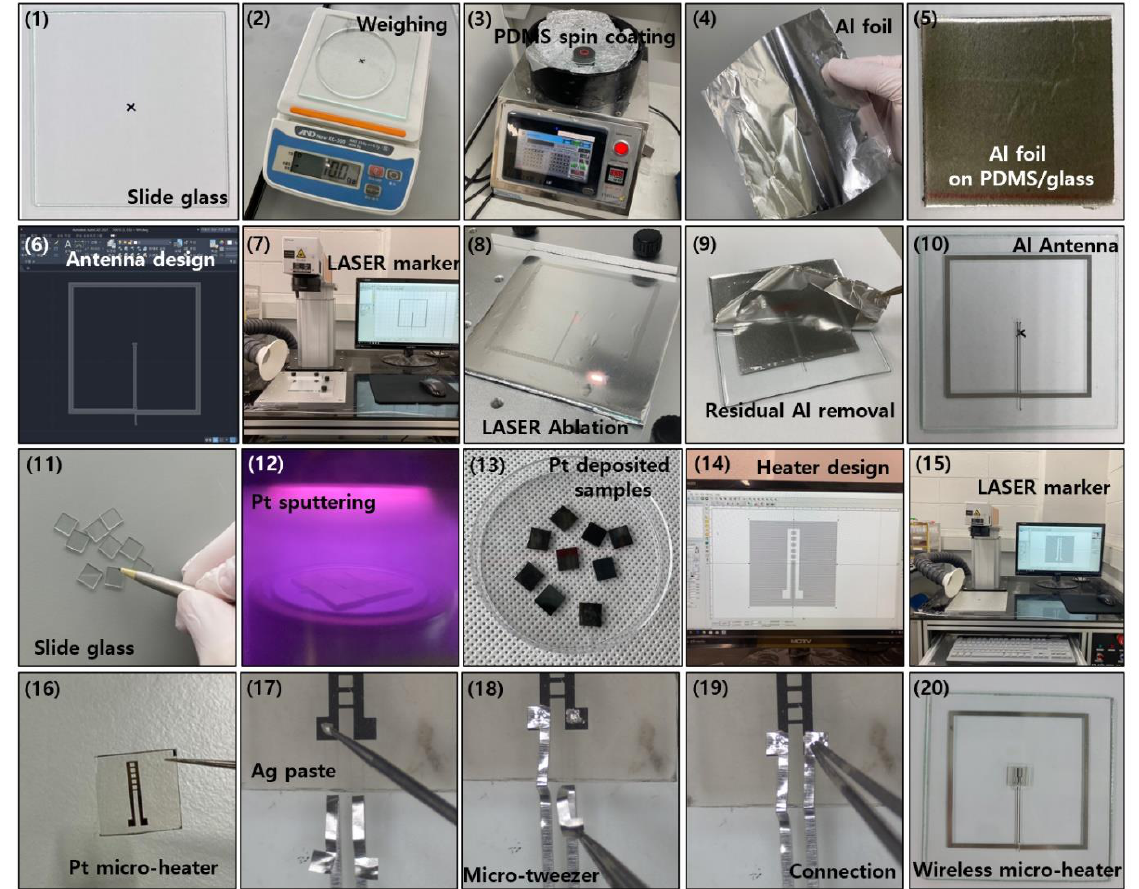
Figure A1. Photographs of the detailed fabrication procedure of a wireless micro-heater consisting of an Al antenna and a Pt micro-heater.